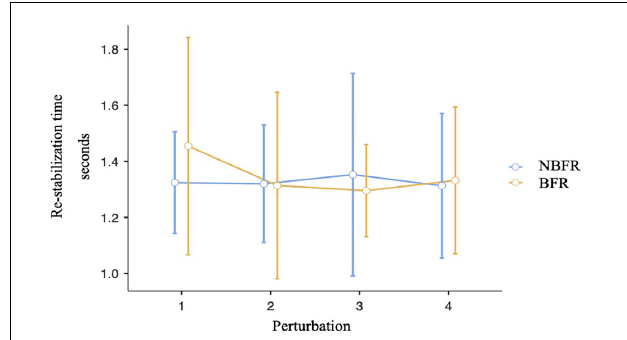
FIGURE 5 | Analysis of the re-stabilization time at the points of perturbation. Mean value comparison and 90% CI. NBFR = No BFR.